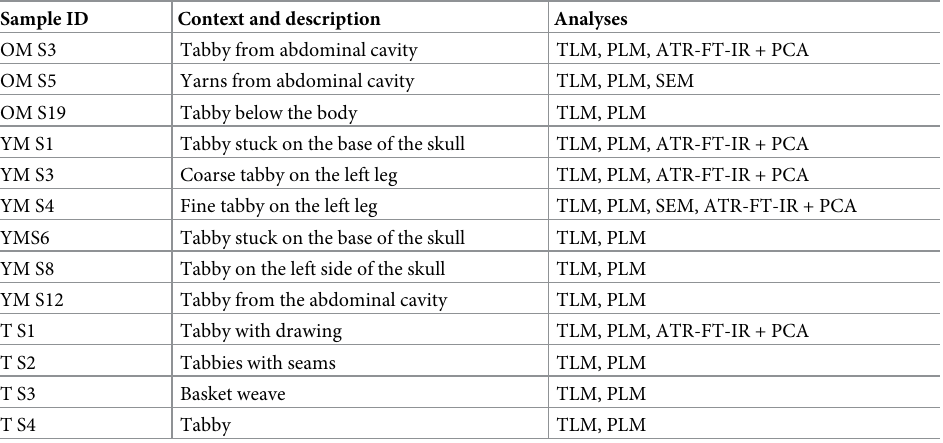
Sample ID Context and